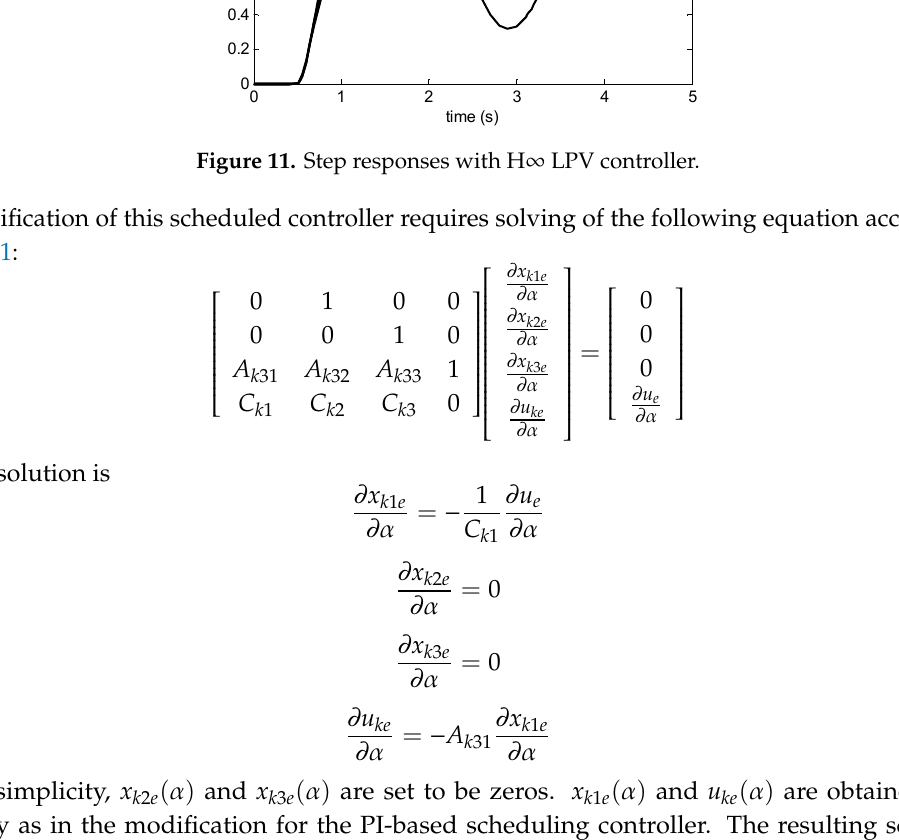
Figure 13. Polynomial fitted result of